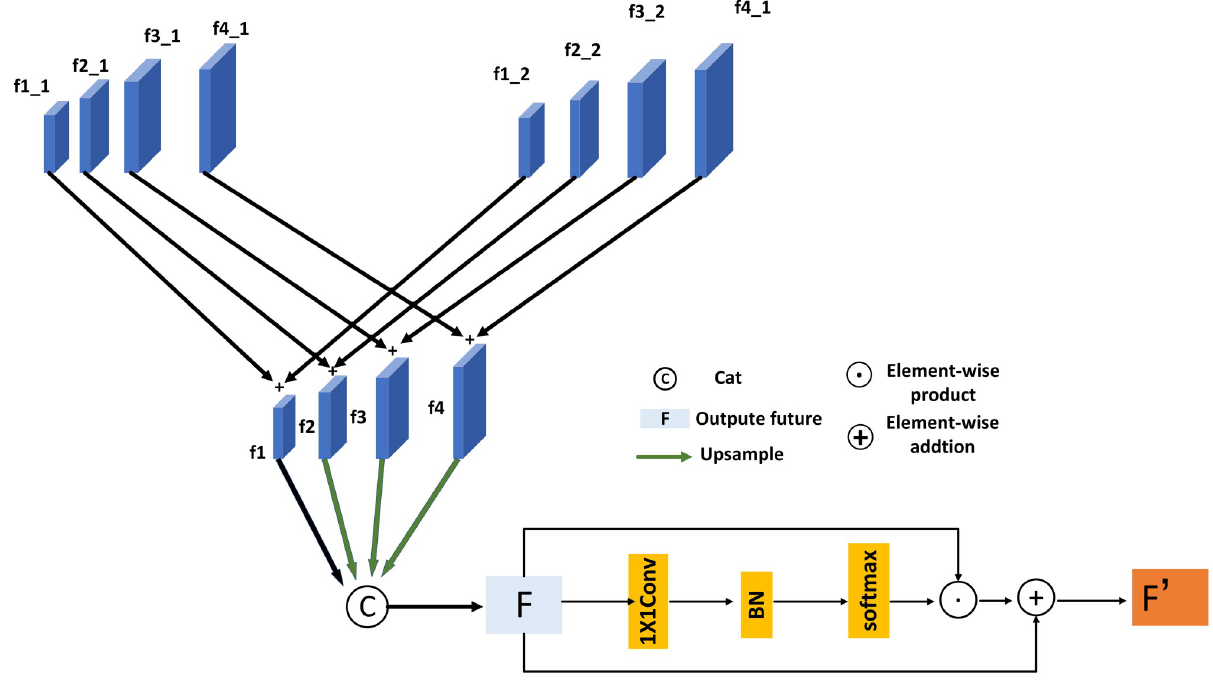
Fig 7. Adaptive fusion module